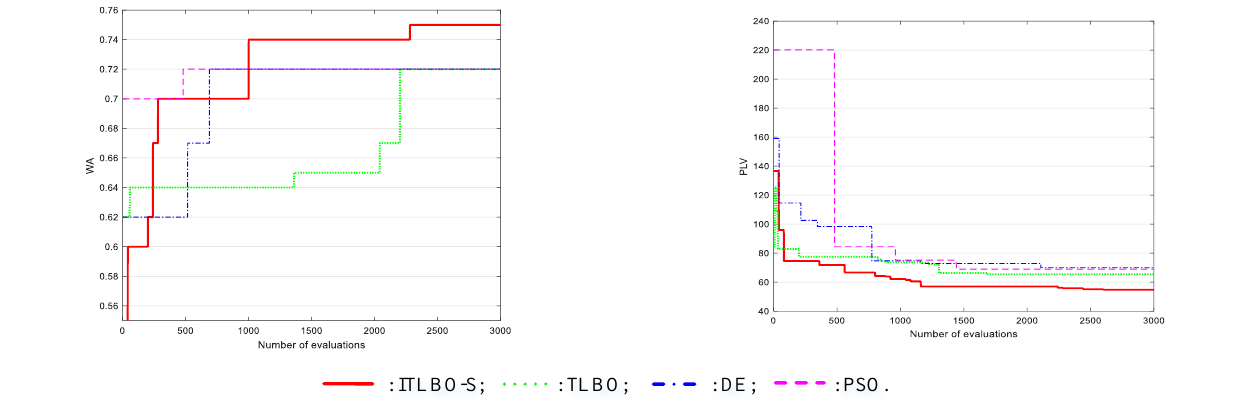
Figure 12. Change trend of wave availability (WA) and personnel load variance (PLV).